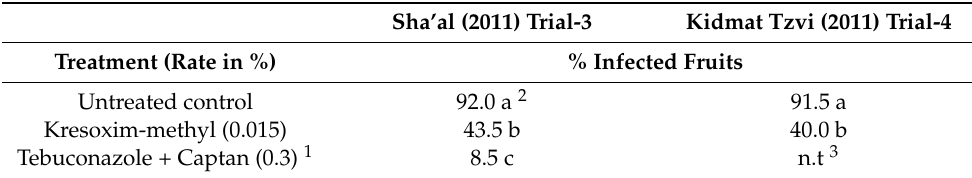
Table 4. Efficacy of Stroby (kresoxim methyl) and Orpan (tebuconazole + captan) in the control of apple scab in orchards in Northern Israel.